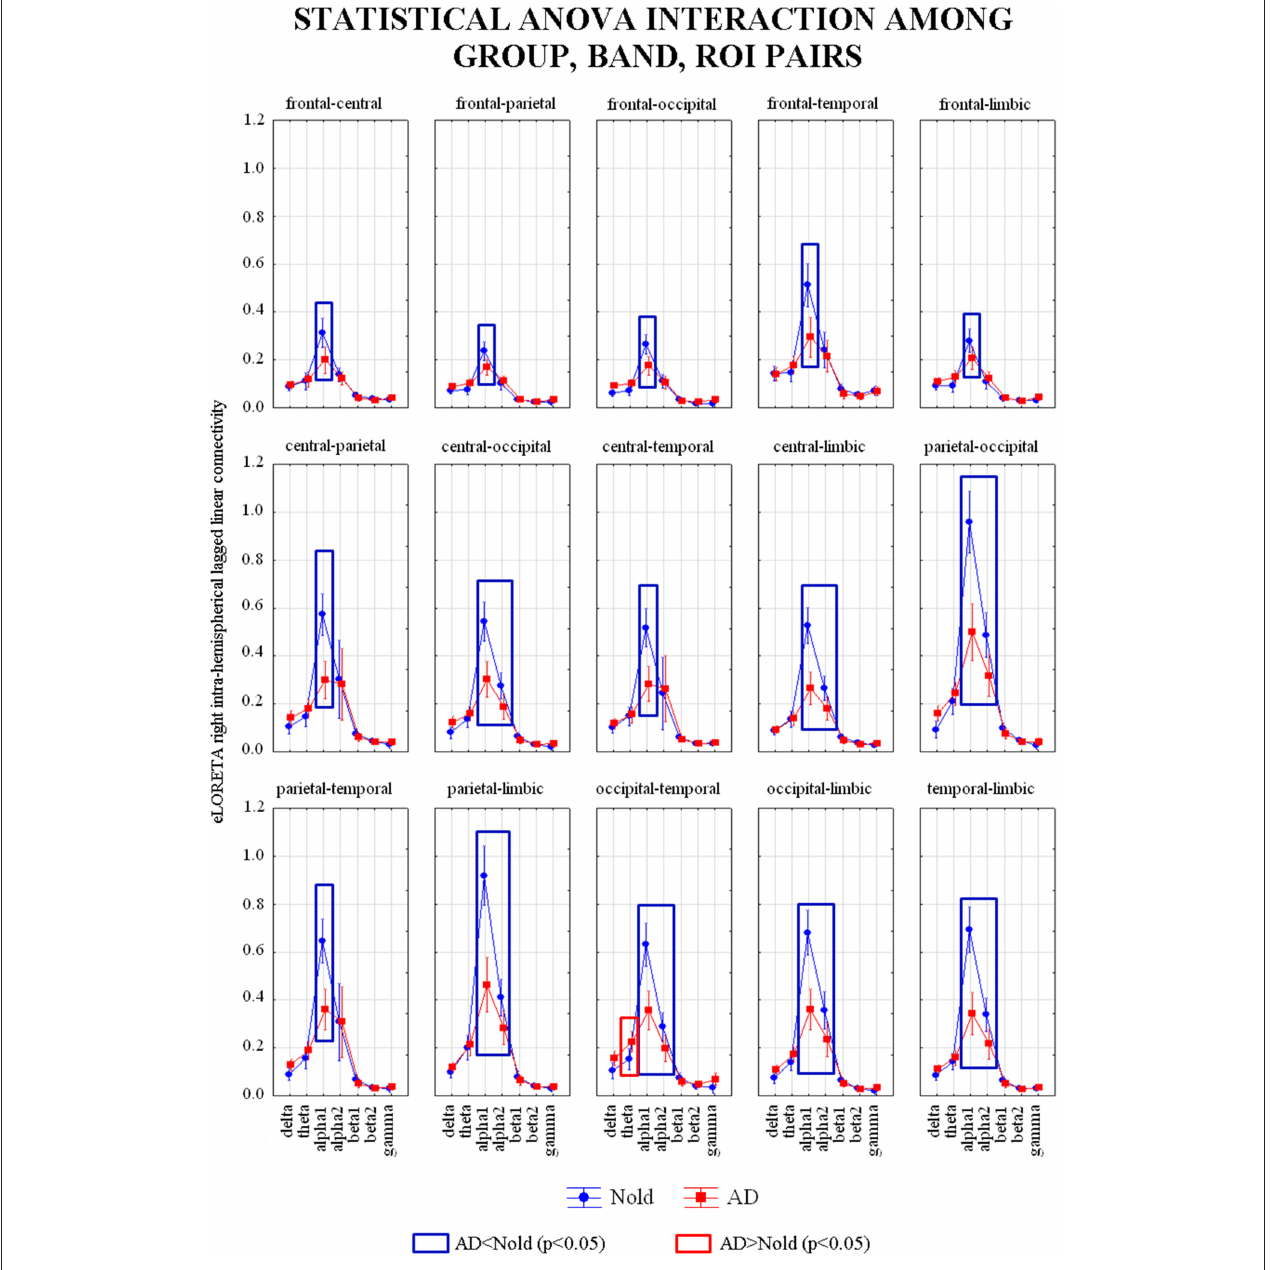
FIGURE 5 | Diagram showing the grand average of the EEG intra-hemispherical lagged linear connectivity computed between each pair of regions of interest (ROI) in the right hemisphere. These values refer a statistically significant ANOVA interaction [ F (84 , 18312) = 4.6296, p < 0.0001] among the factors Group (AD, Nold), ROI pairs (frontal-central, frontal-parietal, frontal-occipital, frontal-temporal, frontal-limbic, central-parietal, central-occipital, central-temporal, central-limbic, parietal-occipital, parietal-temporal, parietal-limbic, occipital-temporal, occipital-limbic, and temporal-limbic), and Band (delta, theta, alpha 1, alpha 2, beta 1, beta 2, gamma). Subjects’ age, education, IAF, and gender were used as covariates. Legend: the rectangles indicate the ROI pairs and frequency bands in which connectivity values presented the pattern Nold 6= AD (Duncan test, p < 0.05).